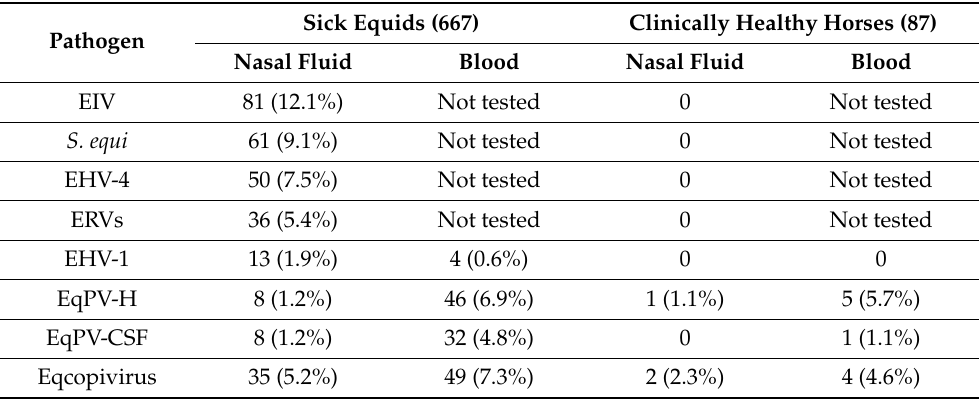
Table 2. Frequency of detection of common respiratory pathogens and newly identified equine parvoviruses in sick and clinically healthy